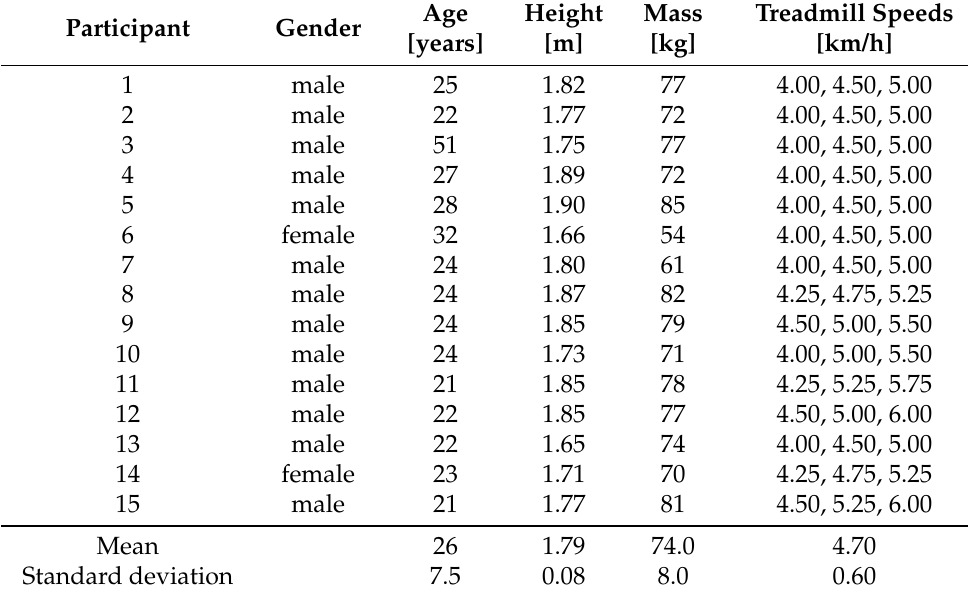
Table 1. Overview of the participants, mean, and standard deviation: gender, age, height, mass and considered treadmill